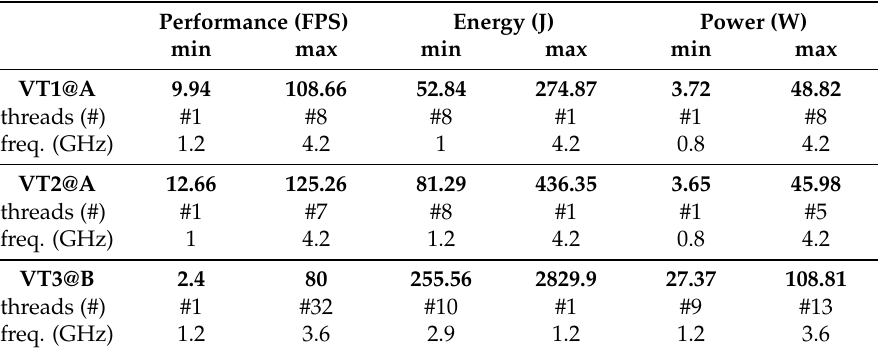
Table 4. HEVC—Energy and